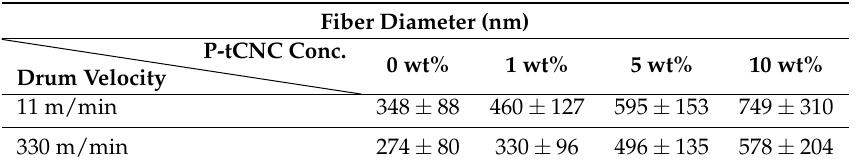
Table 2. Fiber diameter in electrospun PU/P-tCNC mats based on SEM image analysis. The fiber diameter increases with increasing P-tCNC concentration. Fibers collected at 330 m/min exhibited smaller diameters than those collected at 11 m/min.